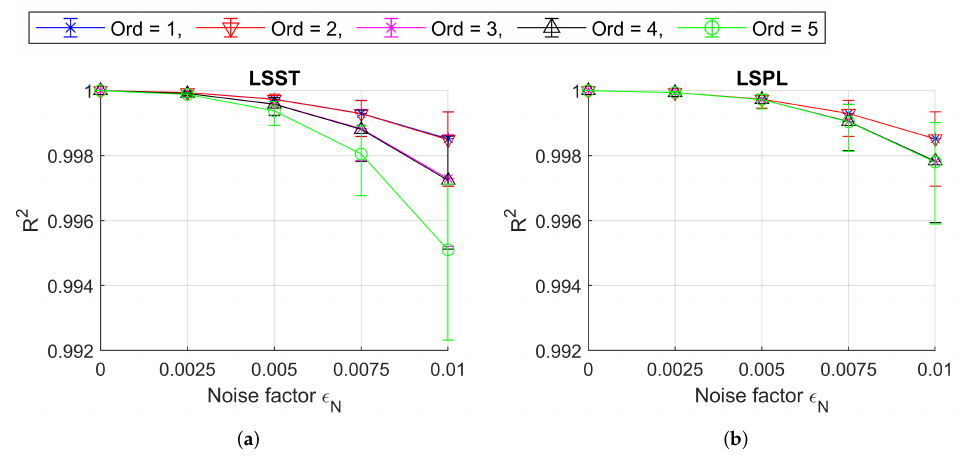
Figure 10. Median and quantile of R 2 with the two methods ( a ) LSST and ( b ) LSPL.